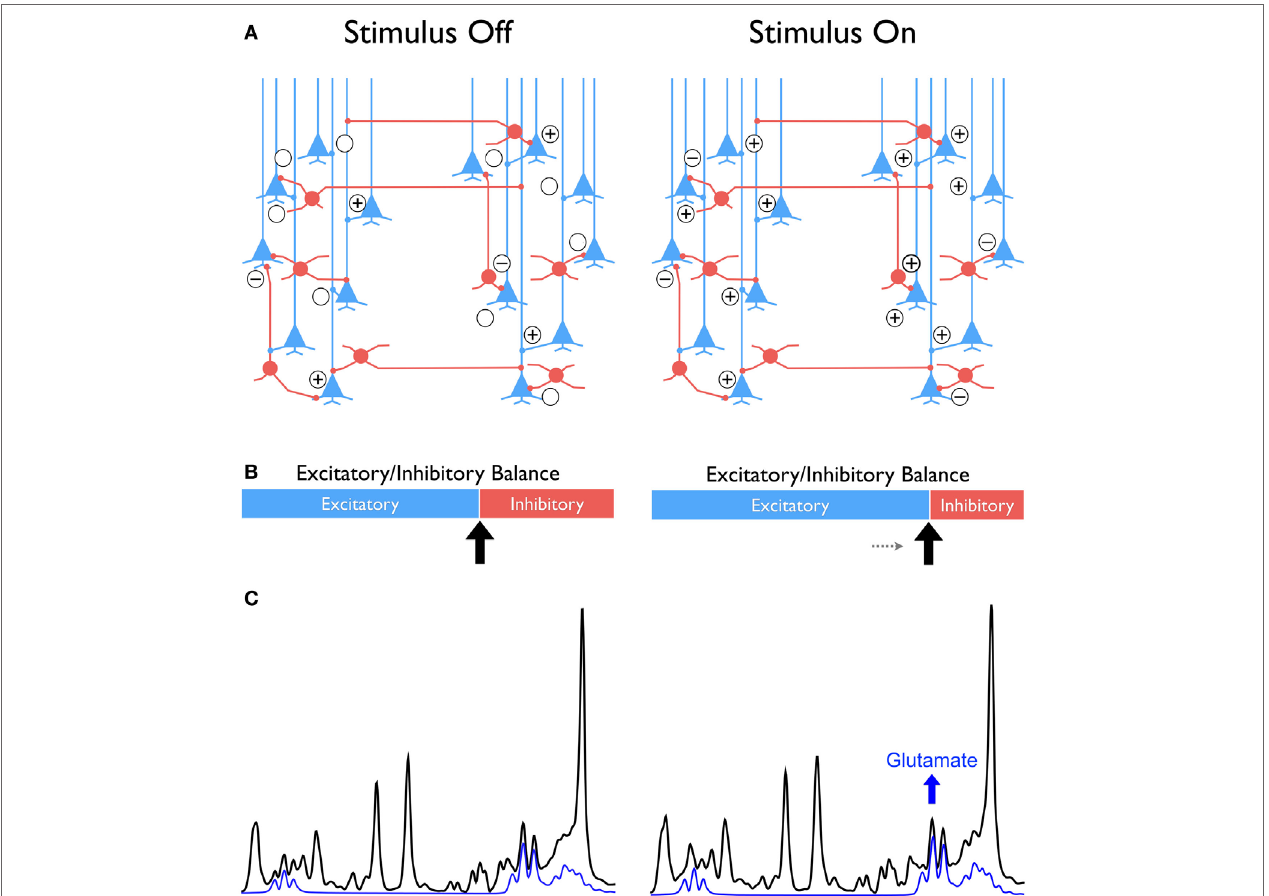
FiguRe 1 | Conceptual framework comparing the “balanced” excitatory and inhibitory (E/I) synaptic drive at stimulus-free and stimulus-dependent conditions in cortex with glutamatergic pyramidal neurons in blue and GABAergic interneurons in red (A) . The difference between conditions is conceptualized as a shift toward greater excitability at stimulus onset compared to a no-stimulus condition that is represented as sliding bars with excitatory in blue and inhibition in red (B) . This shift leads to a new metabolic steady state reflected in the increased glutamate as illustrated in the individual signal in blue extracted from the 1 H MRS spectrum shown in black (C) . The “ + ” and “ − ” symbols signify the excitatory and inhibitory synaptic activity, respectively.